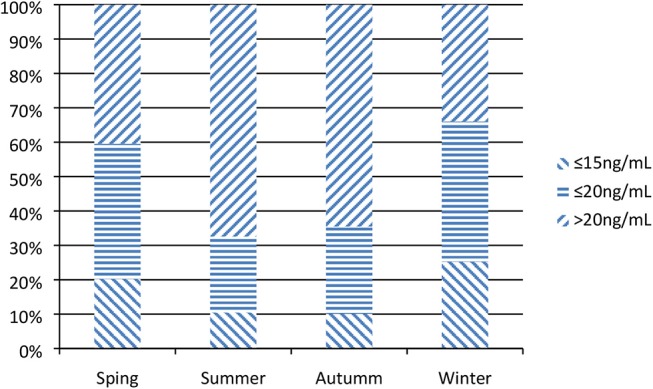
Seasonal variation of vitamin D in critically ill children.